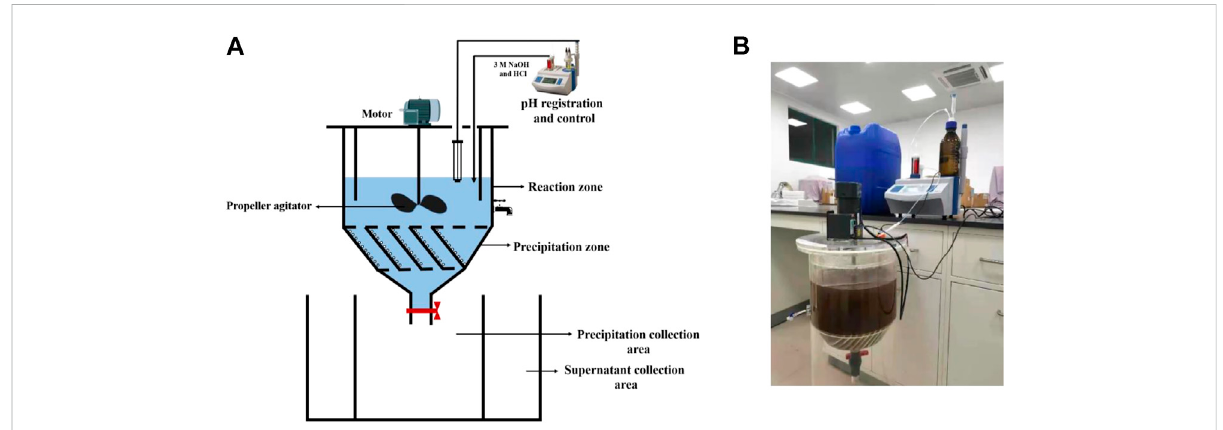
FIGURE 1 (A) Experimental set up of the stirred tank reactor for the pilot test; (B) picture of the reactor used in this